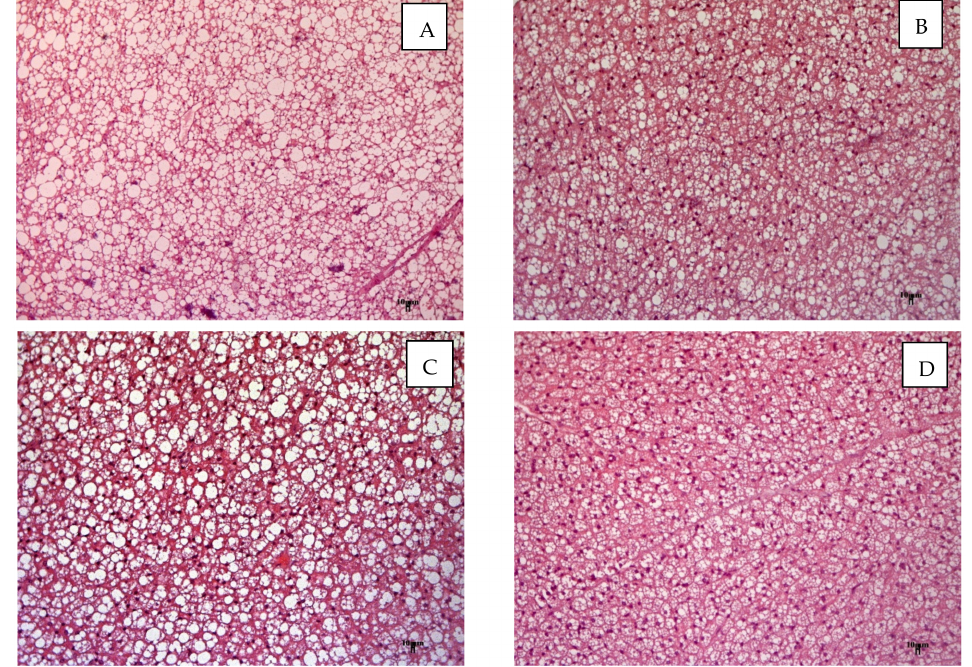
Figure 7. Histological evaluation of brown fat in mice after 4 weeks of experiment. ( A ) AY mice (un- treated), ( B ) AY mice treated by metformin at a dose of 250 mg/kg, ( C ) AY mice treated by compound 2e at a dose of 15 mg/kg, ( D ) C57Bl/6 (healthy control). Hematoxylin and eosin staining, ×